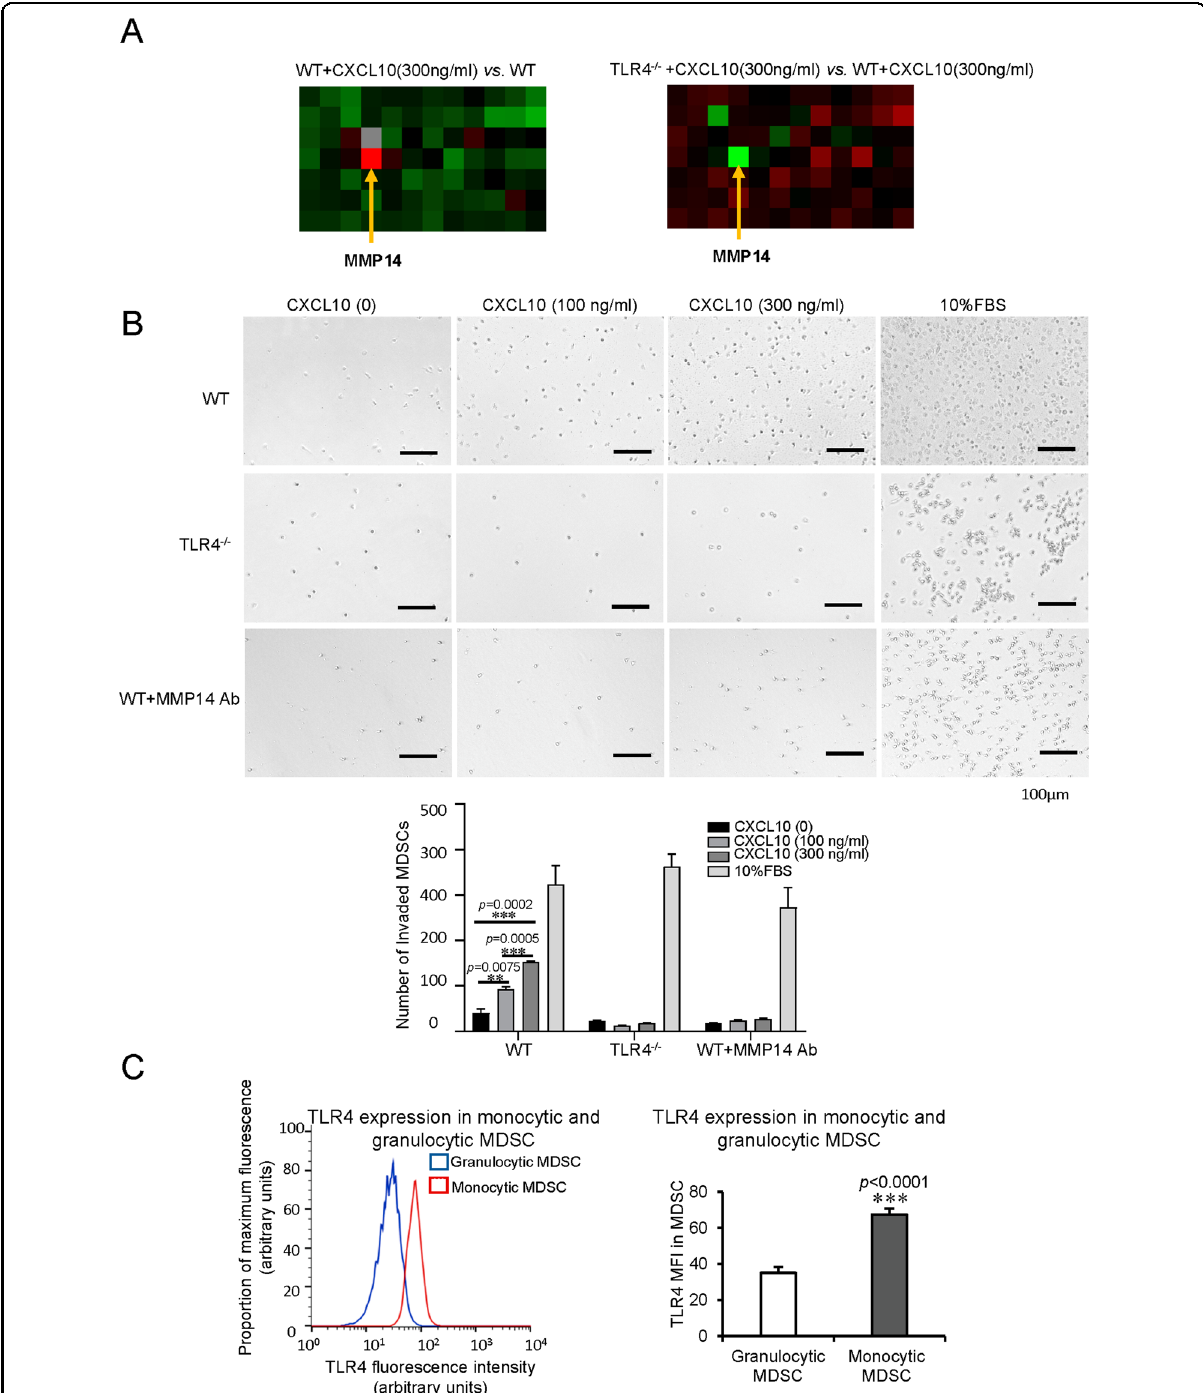
Fig. 5 MDSC mobilization regulated by CXCL10/TLR4 through MMP14 and higher levels of TLR4 on monocytic MDSCs. A MMP14, as the most up-regulated gene, in wild type MDSCs with CXCL10 addition compared to those without treatment; MMP14, as the most down-regulated gene, in TLR4 − / − MDSCs compared to wild type ones with the same CXCL10 treatment by the screen of mouse motility genes. B More wild type MDSCs transferred to the bottom well in a CXCL10 dosage-dependent manner, while no signi fi cantly changed numbers of TLR4 − / − MDSCs and MMP14 Ab-blocking wild type MDSCs (30 μ g/ml) in the bottom well with/without CXCL10 addition. C Augmentation of TLR4 on monocytic MDSCs in contrast with granulocytic MDSCs in mouse IRH model ( N = 6/group). Scale bars: 100 μ m. Error bars indicate standard error of mean; *p < 0.05, ** p < 0.01, *** p < 0.001. MDSC myeloid-derived suppressor cell, MMP14 matrix metallopeptidase 14, Ab antibody, IRH ischemia/reperfusion plus major hepatectomy, WT wild